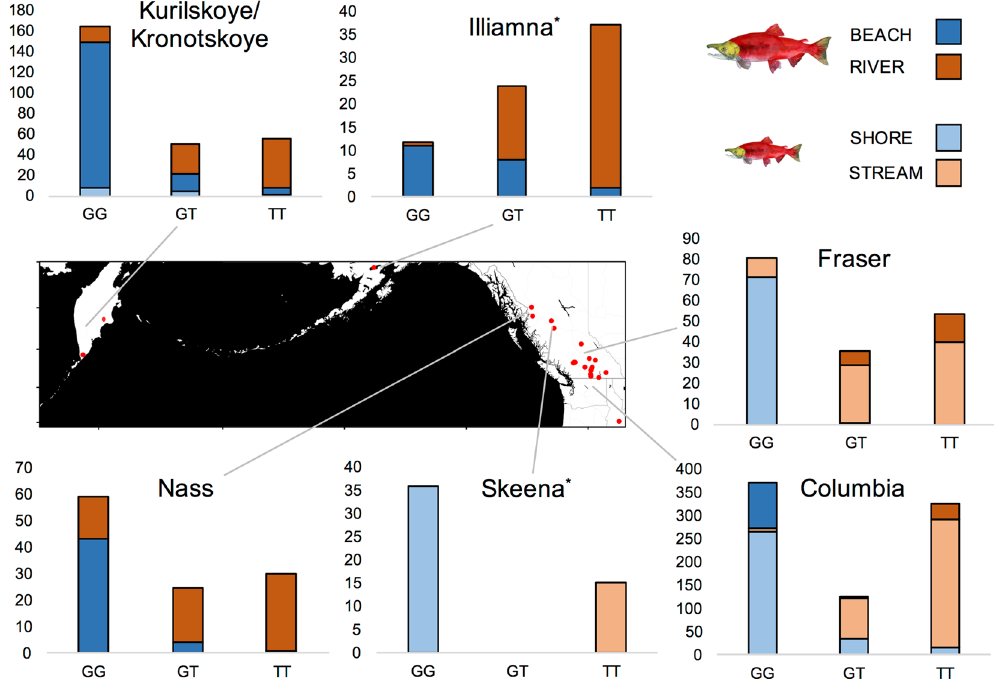
Figure 2. Genotype frequencies at One_LRRC9_68810 of Oncorhynchus nerka migratory and reproductive ecotypes across the major catchments sampled in this study. Plot shading indicates the proportion of each genotype per ecotype per catchment, with colors indicated in the inset legend and general location shown on the map. The Illiamna plot includes all localities within the catchment indicated in Fig. 1 and Table 1 except for the island beach-spawning sockeye salmon samples (Fuel Dump Island and Woody Island). The Skeena plot includes all localities within the catchment indicated in Fig. 1 and Table 1 except for the Drew Creek samples from Tchesinkut Lake (see Discussion in main text for more details). Genotype frequencies from the Vancouver Island catchment are also not shown, as we only have three samples from a single site (Cowichan Lake). All three of these shore-spawning kokanee possessed the predicted GG genotype. Genotype frequencies for all sample sites are given in Table S3. The map was generated in R 67 using the ggmap package 68 with map tiles by Stamen Design (www.stamen.com), under CC BY 3.0 (creativecommons.org/licenses/by/3.0/) and data by OpenStreetMap (www.openstreetmap.org/), under ODbL (www.openstreetmap.org/copyright).